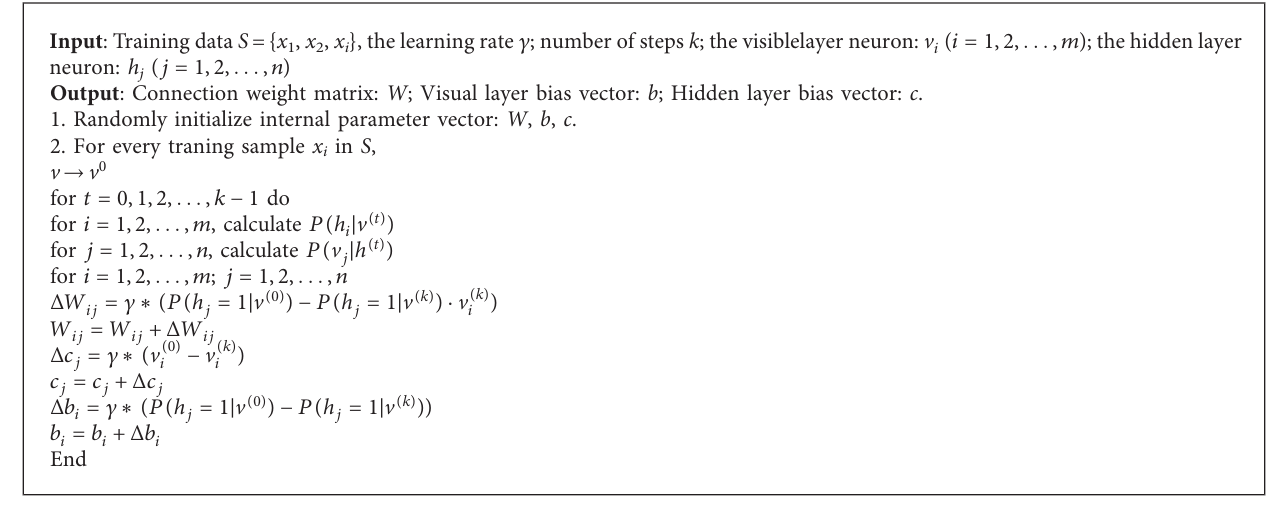
A LGORITHM 1: CD-k algorithm for the